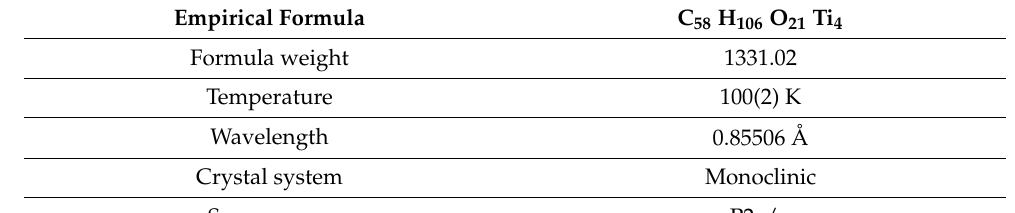
Table 1. Crystal data and structure refinement for ( 1